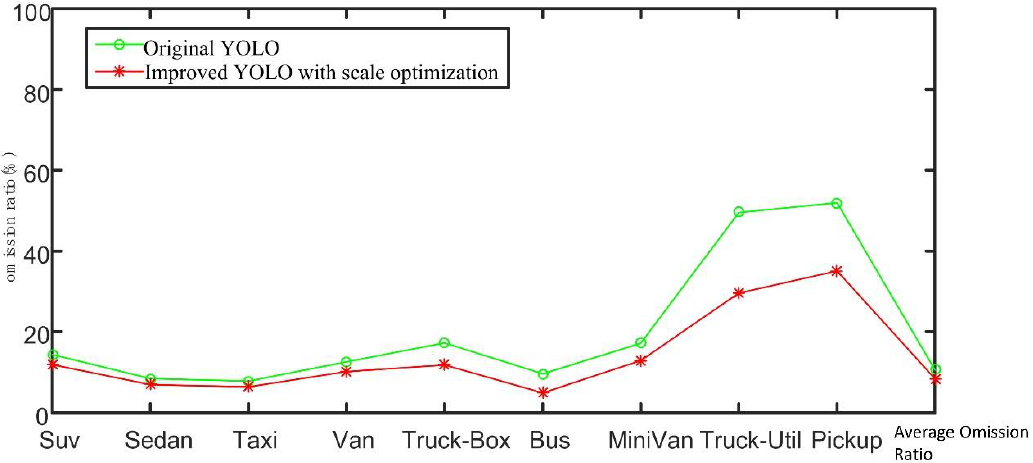
Table 2. The confusion matrix of the improved YOLO algorithm (unit %).